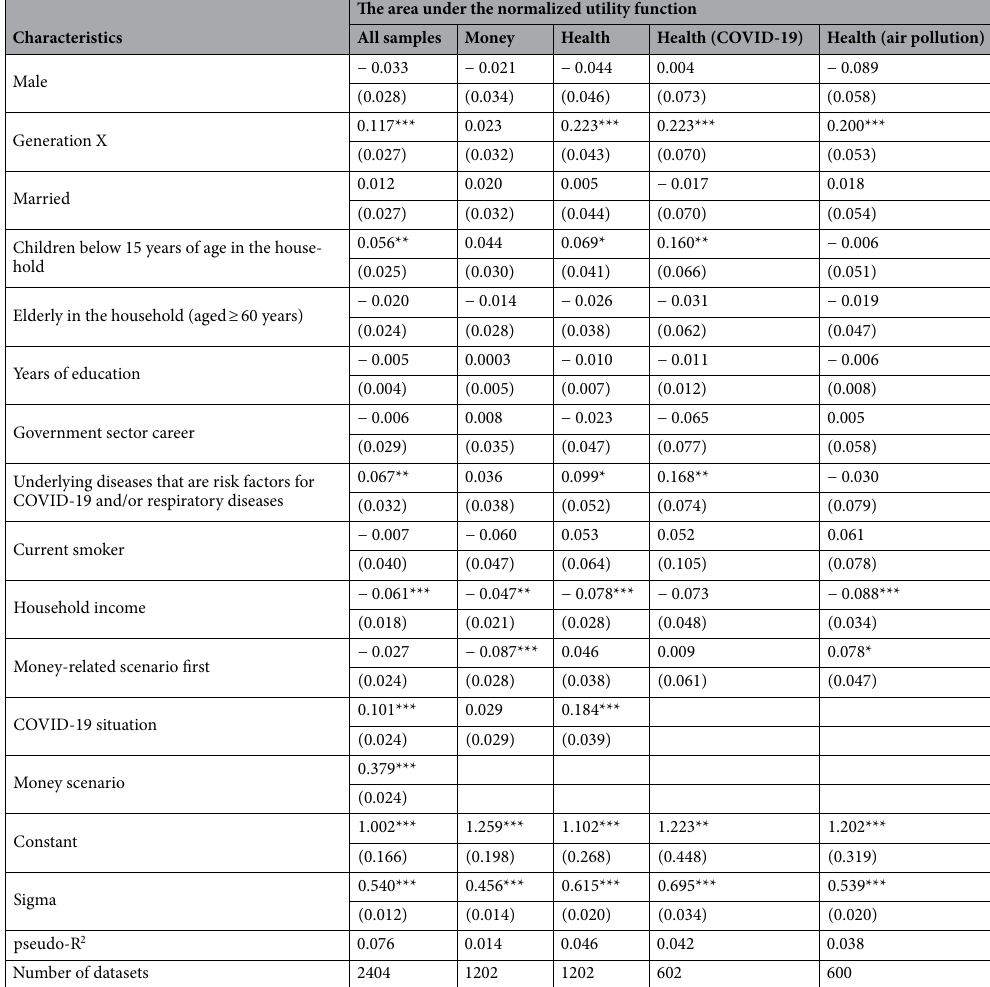
Table 4. The effect of socio-demographic characteristics on discounting. COVID-19, Coronavirus Disease 2019. Remarks: (1) ( ) depicts the standard error. (2) Tobit model, with the left-censored value at 0 and the right-censored value at 1. (3) *,**,*** denote statistically significant at the 0.01, 0.05, and 0.1 levels,